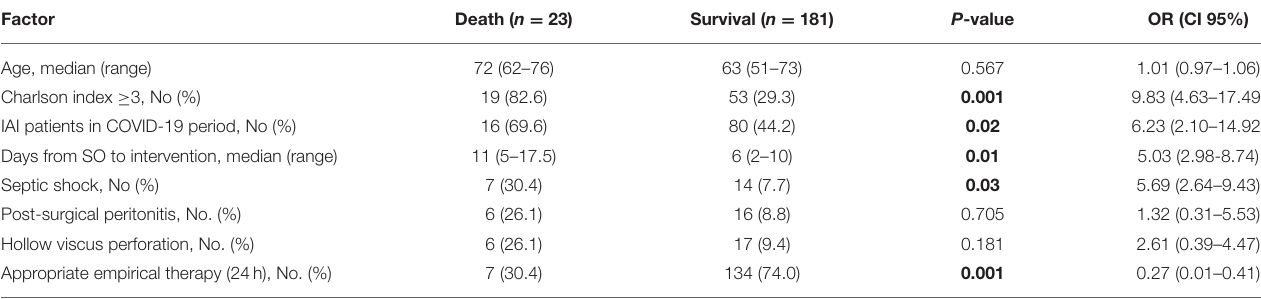
TABLE 3 | Multivariate analysis of the factors related to death in a combined cohort of the pre-COVID-19 pandemic cohort and the COVID-19 pandemic cohort. Factor Death ( n = 23) Survival ( n =